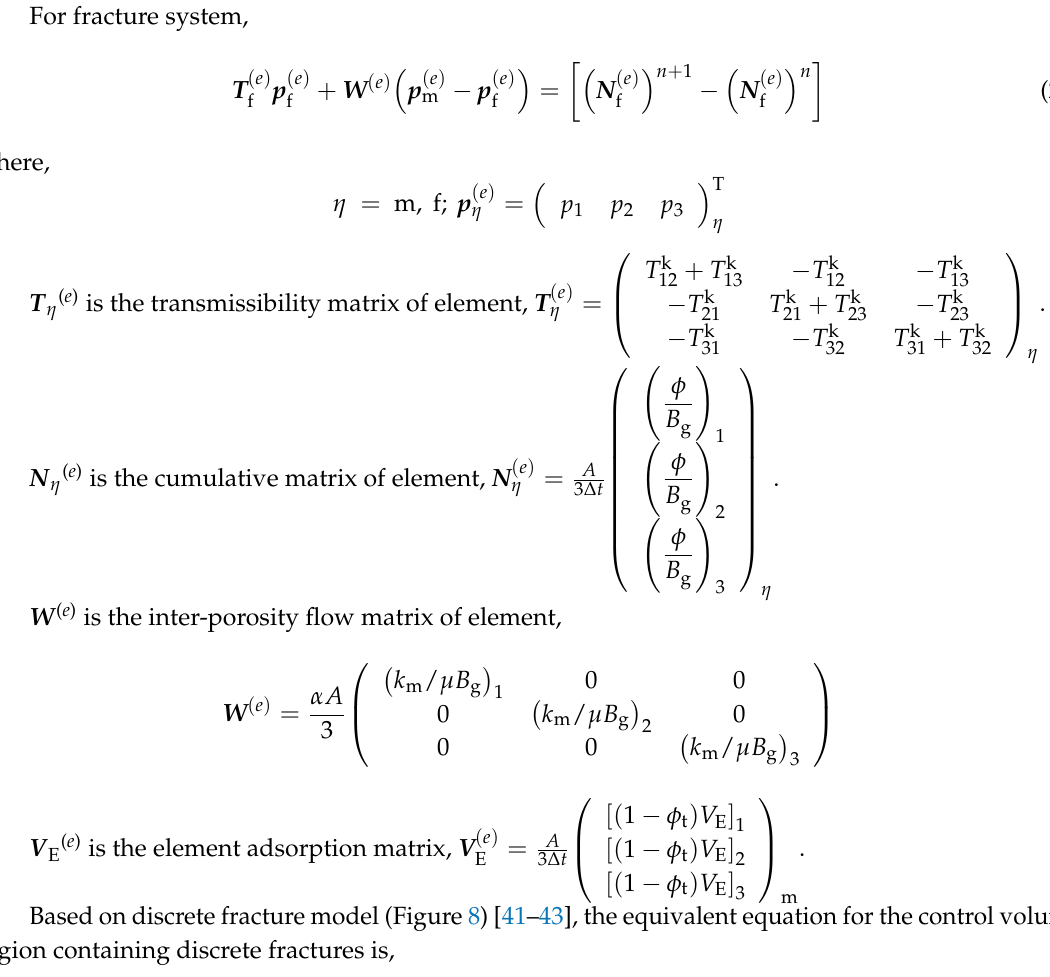
Figure 7. The typical triangle element.